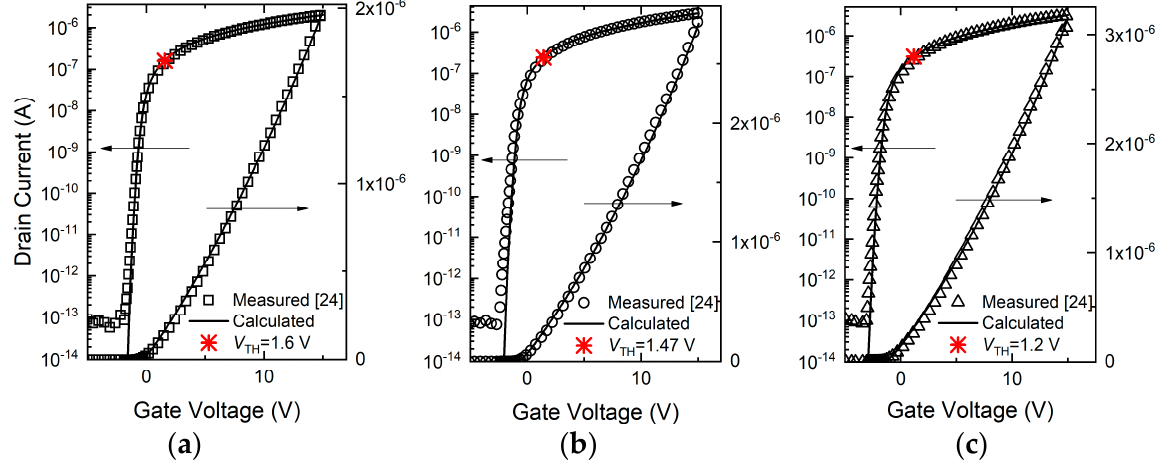
Figure 5. Transfer curves ( V DS = 0.5 V) calculated by Equation (20) compared with measured data of three different devices ( a – c ) [24], with V TH by Equation (12) marked in figures. Table 1. Parameters in Figures 2–5.